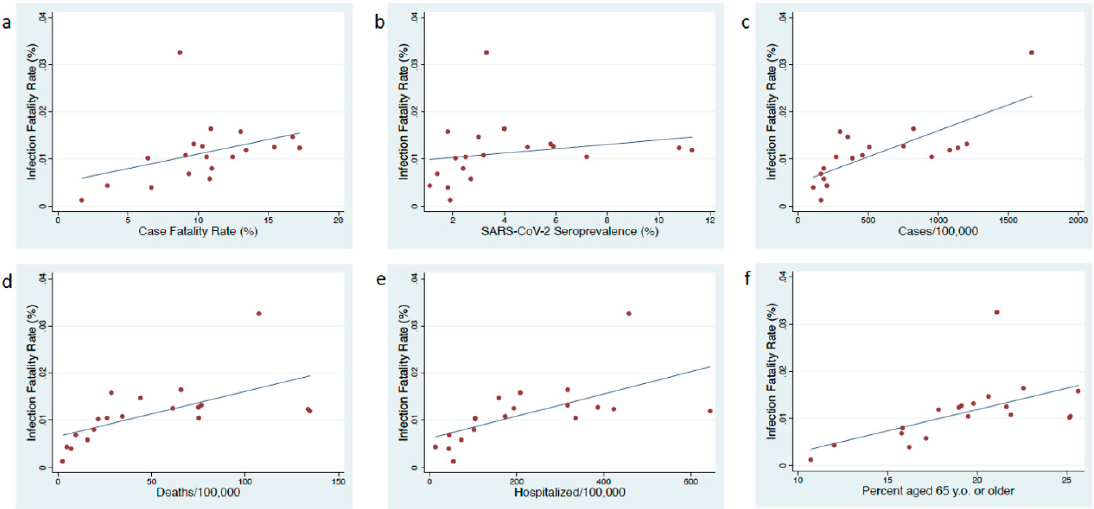
Figure 1. Scatter plot of infection fatality rate versus case fatality rate ( a ), seroprevalence of SARS-CoV-2 ( b ), cumulative number of cases of COVID-19 / 100,000 ( c ), COVID-19 attributable mortality / 100,000 ( d ) and COVID-19 attributable hospitalization / 100,000 ( e ) in 19 Spanish regions ( f ) percent of the population 65 years or older.